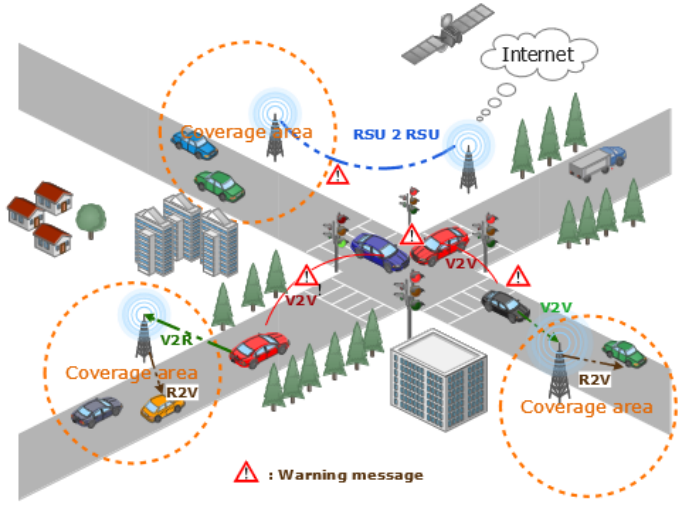
Figure 1. Communication modes in